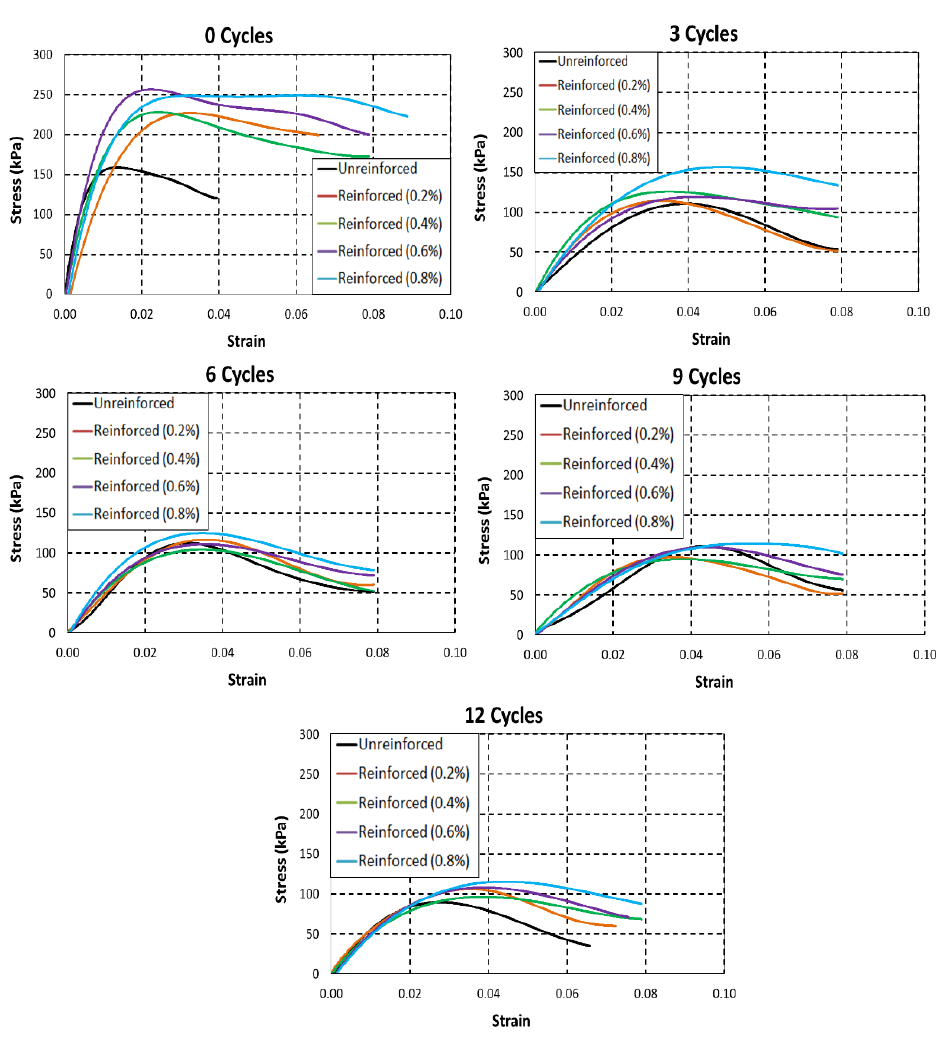
Figure 3: Stress–strain curves of samples at (a) 0 cycle, (b) 3 cycles, (c) 6 cycles, (d) 9 cycles, (e)12 cycles.